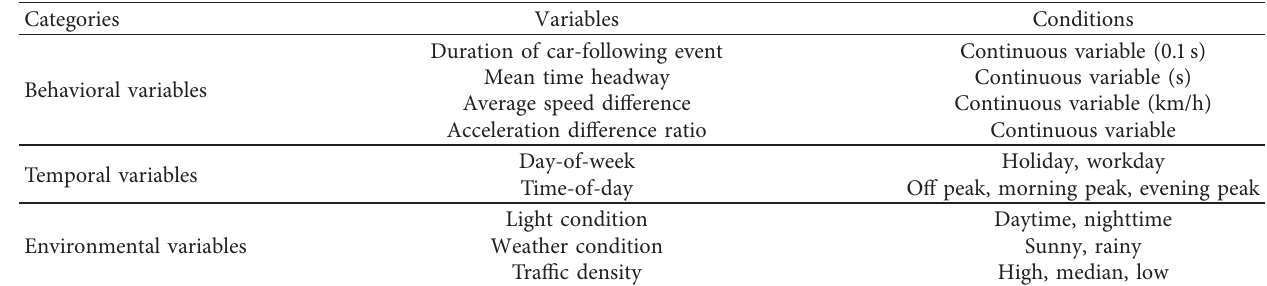
Table 2: Summary of independent